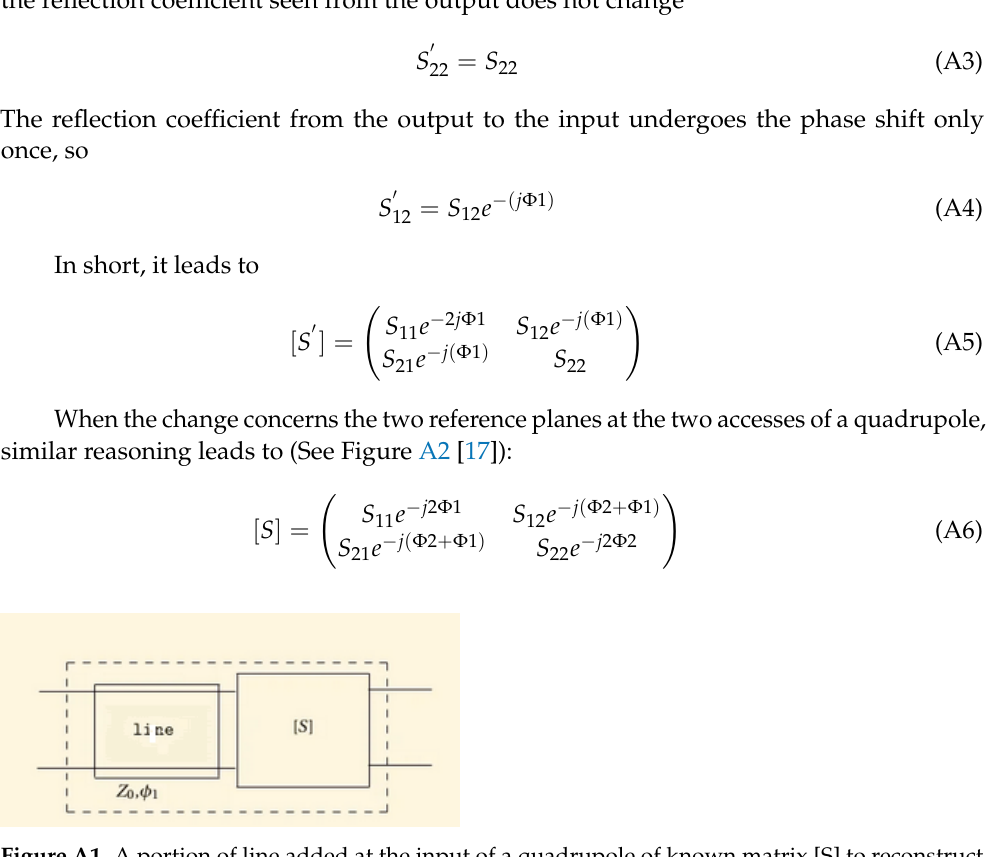
Figure A1. A portion of line added at the input of a quadrupole of known matrix [S] to reconstruct the phase established between 2 sources: we can work on the cases of symmetries as particular cases where the sources are in phase or opposition of phase) [17].